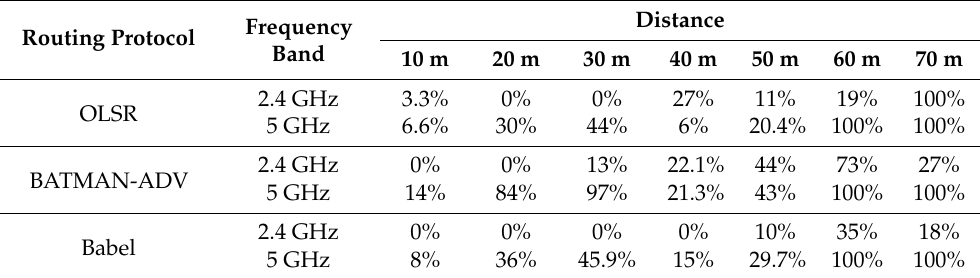
Figure 3. Average throughput (Mbps) vs. distance (meters) for each protocol and frequency band. Table 4. Average packet loss (%) obtained between PCs-UAVs at different gap distances for OLSR, BATMAN-ADV, and Babel, for 2 frequency bands: 2.4 and 5 GHz. Each measurement had a duration of 60